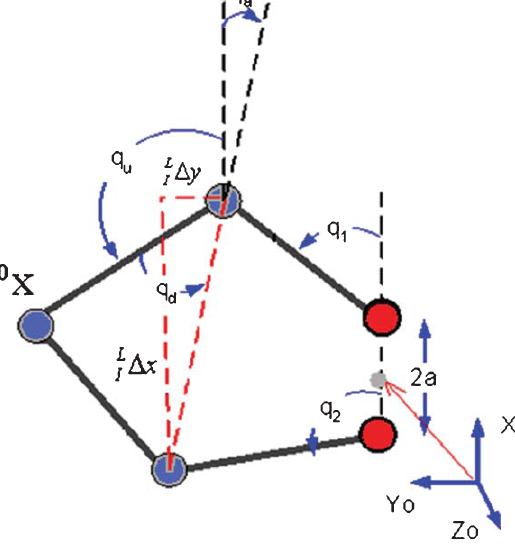
Fig. 2. Device kinematic